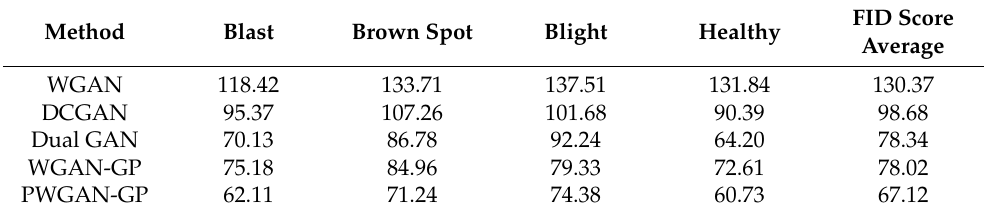
Table 5. Generation Result Evaluation of GANs by FID